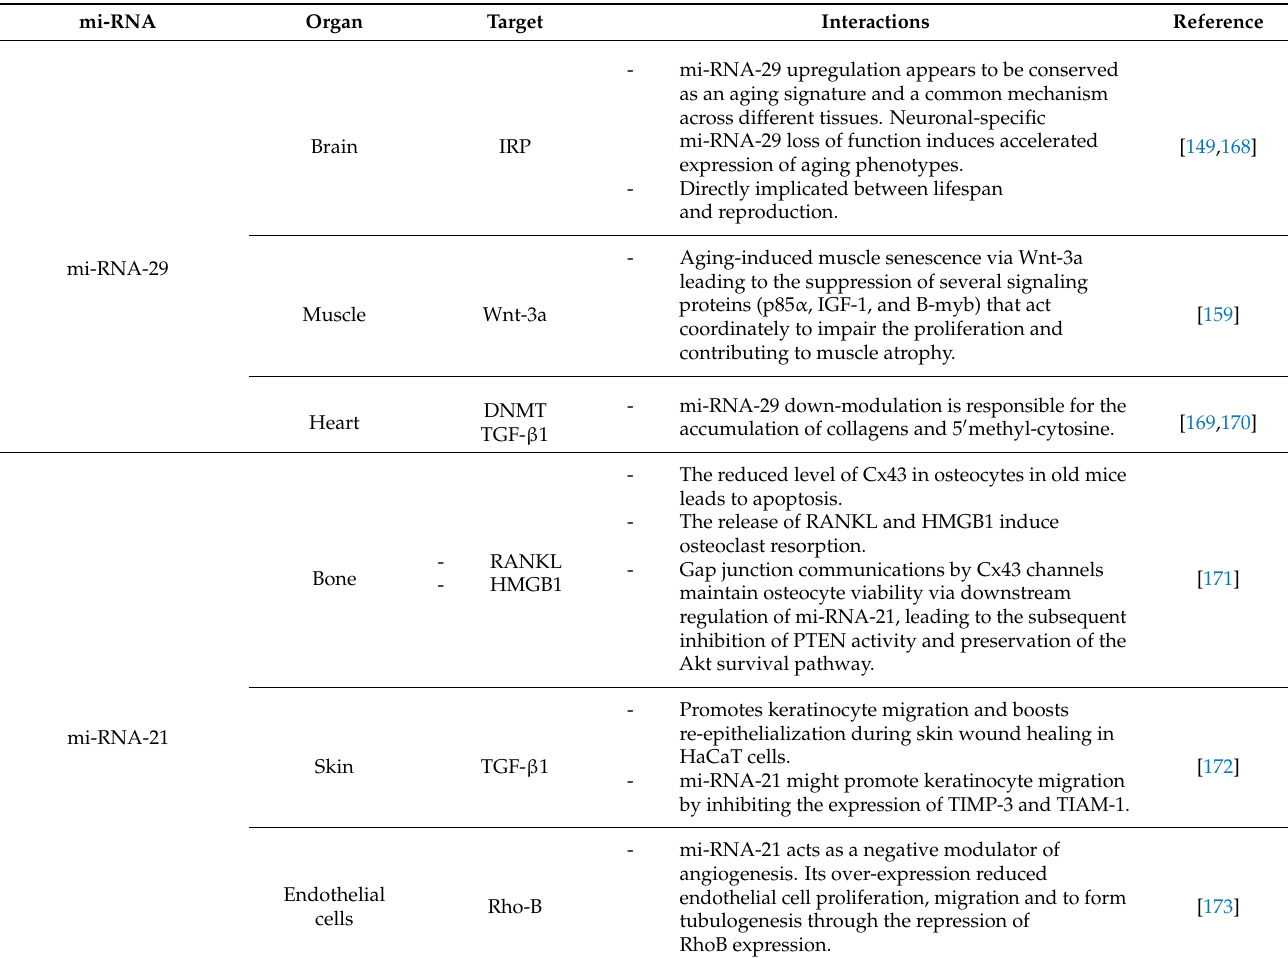
Table 1. Mi-RNA interaction in organs in the aging process. IRP: Iron responsive proteins; Wnt-3a: Wingless-type MMTV integration site family member-3A; p85 α : Phosphatidylinositol 3-kinase regulatory subunit alpha; IGF-1: insulin-like growth factor I; B-myb: Myb-related protein B; DNMT: DNA methyltransferase; TGF- β 1: transforming growth factor beta 1; Cx43: Connexin 43; RANKL: receptor activator of NF κ B ligand; HMGB1: high-mobility group box-1; PTEN: phosphatase and tensin homolog; Akt: protein kinase B; HaCaT: spontaneously immortalized human skin keratinocytes; TIMP-3: tissue inhibitor of metalloproteinase 3; TIAM-1: T-lymphoma invasion and metastasis-inducing protein 1; Rho-B: RAS homolog family member B; MeCP2: methyl CpG binding protein 2; XIAP: X-linked inhibitor of apoptosis; ECM: extracellular matrix; COL16A-1: Collagen XVI; DEJ: dermal–epidermal junction; TNF- α : tumor necrosis factor- α ; SIRT: Sirtuins; mTOR: mechanistic target of rapamycin; BMP2: bone morphogenetic proteins 2; Hmox1: heme oxygenase-1; P38-MAPK: